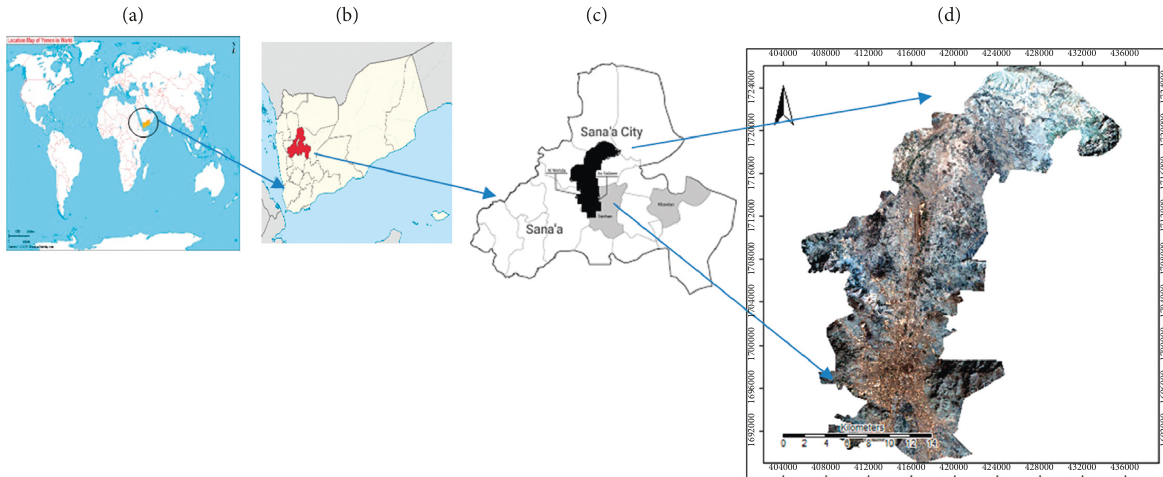
Figure 2: The location of Sana’a. (a) The world; (b) Yemen country; (c) Sana’a governorate; (d) Sana’a city. Table 4: Downloaded images specification of this study. Data